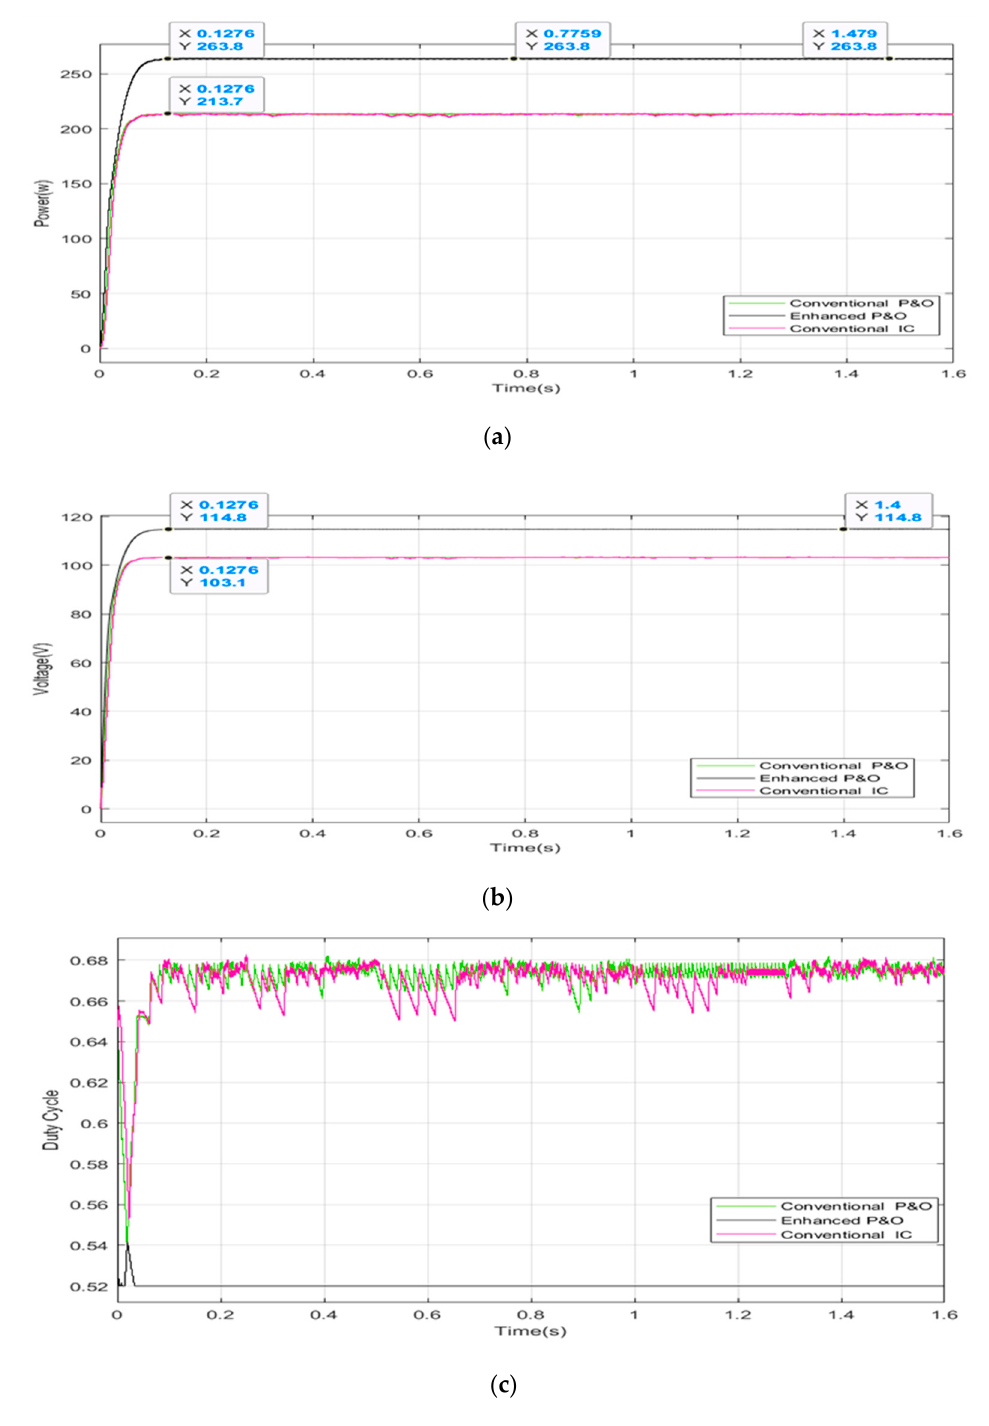
Figure 14. The simulation results of the proposed technique and the conventional P&O and IC techniques for Case Four: ( a ) Tracked output power; ( b ) Output voltage of the boost converter; ( c ) Duty cycle behaviors.